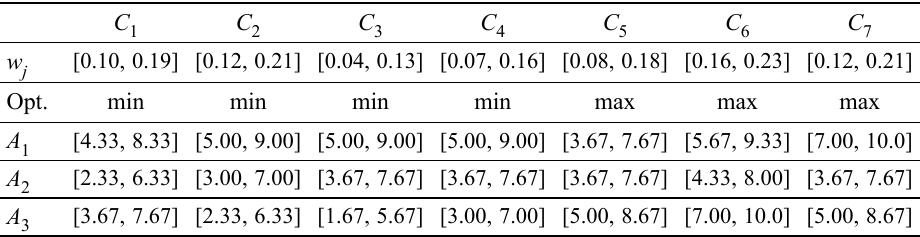
Table 5. Grey decision matrix